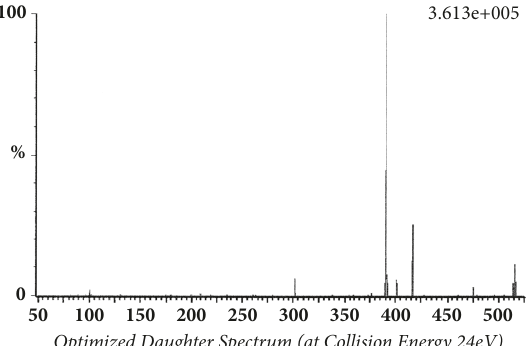
Figure 4: Transition of glimepiride sodium adduct to daughter fragment (m/z 513.19 > 374).